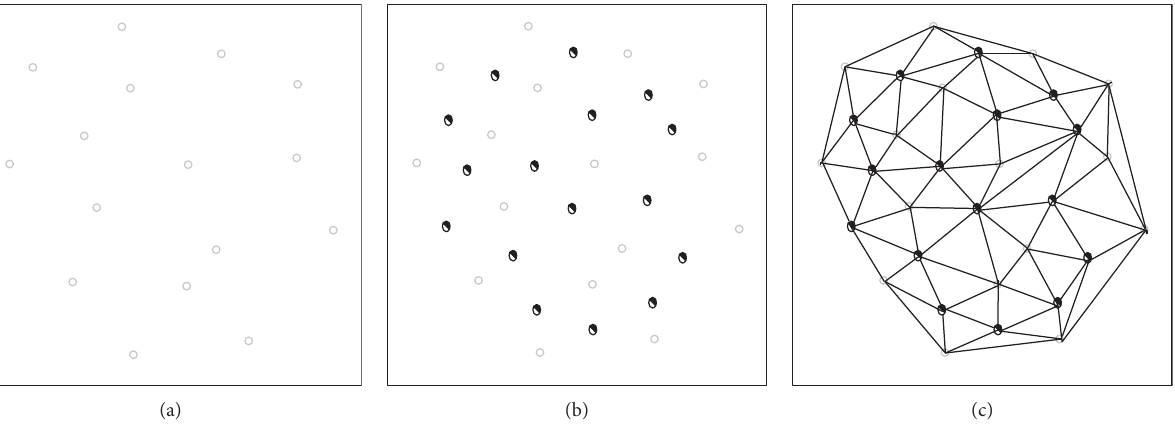
Figure 2: Steps of the interpolation method of triangulation combined with BP neural network: (a) scattered measured data points; (b) random virtual data points; (c) all triangles formed with data points as vertices.